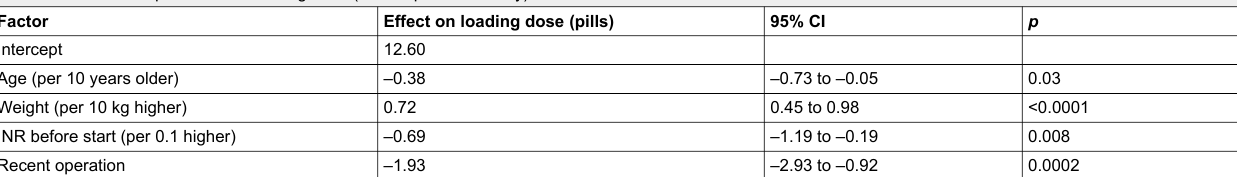
Table 4: Multivariate predictors of loading dose (clinical predictors